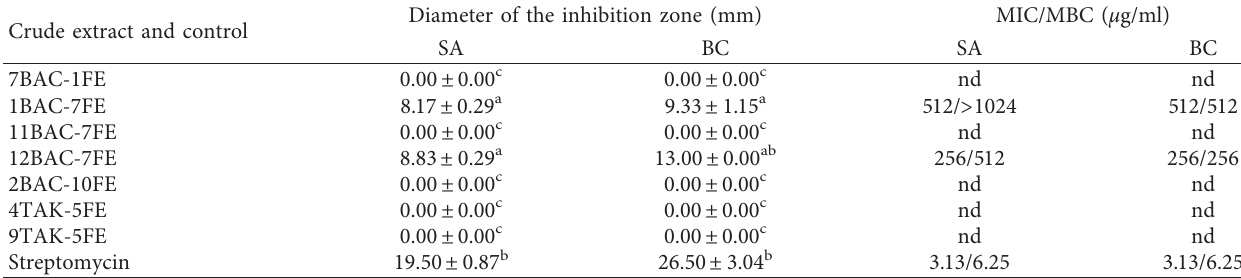
Table 4: Antibacterial property of crude extracts against selected pathogenic bacteria determined using the agar well diffusion assay and colorimetric broth microdilution